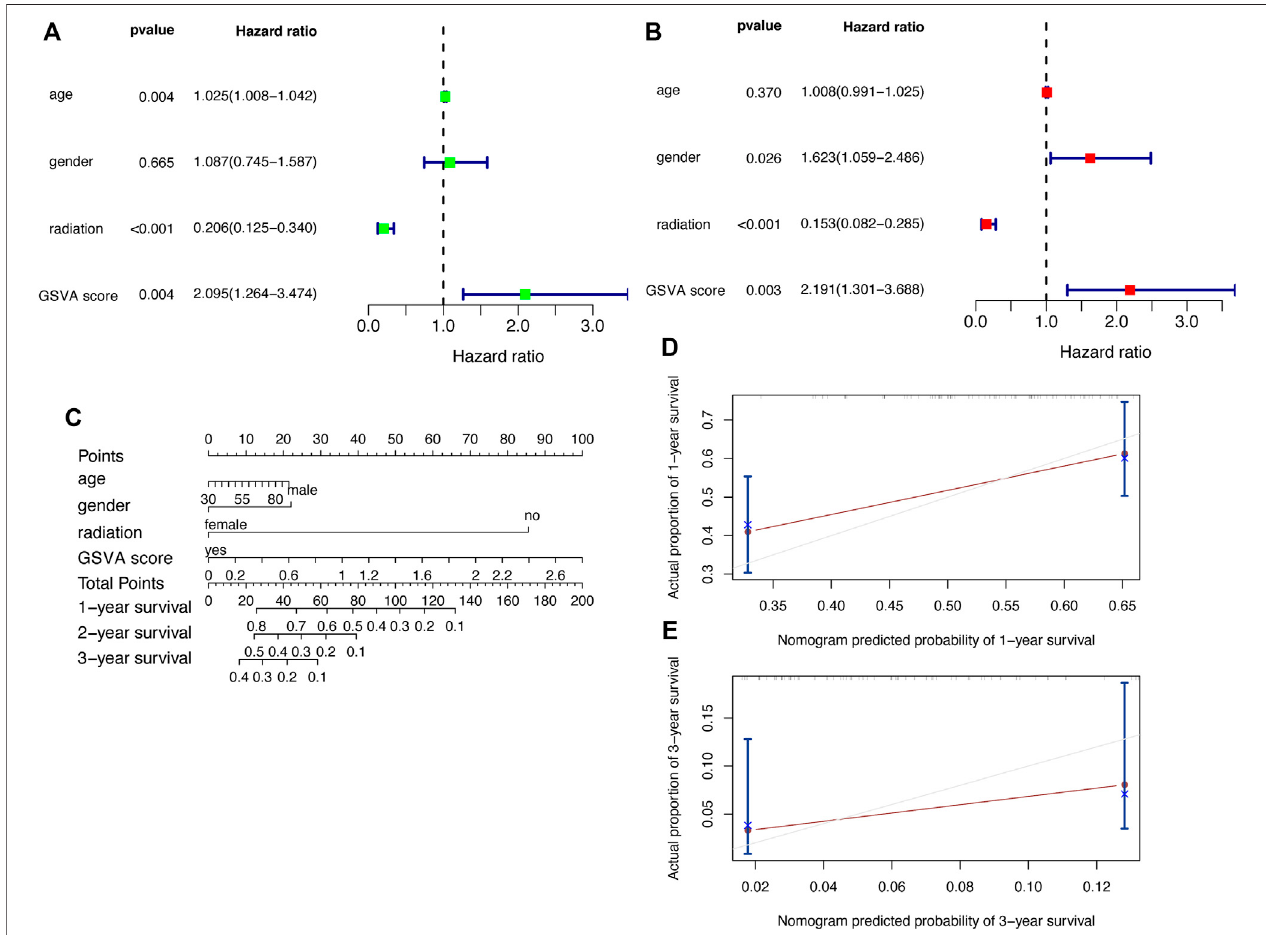
FIGURE 8 | Validation of the prognostic model with clinical factors (A) Univariate Cox regression analysis (B) Multivariate Cox regression analysis (C) Nomogram (D,E) Calibration curves.